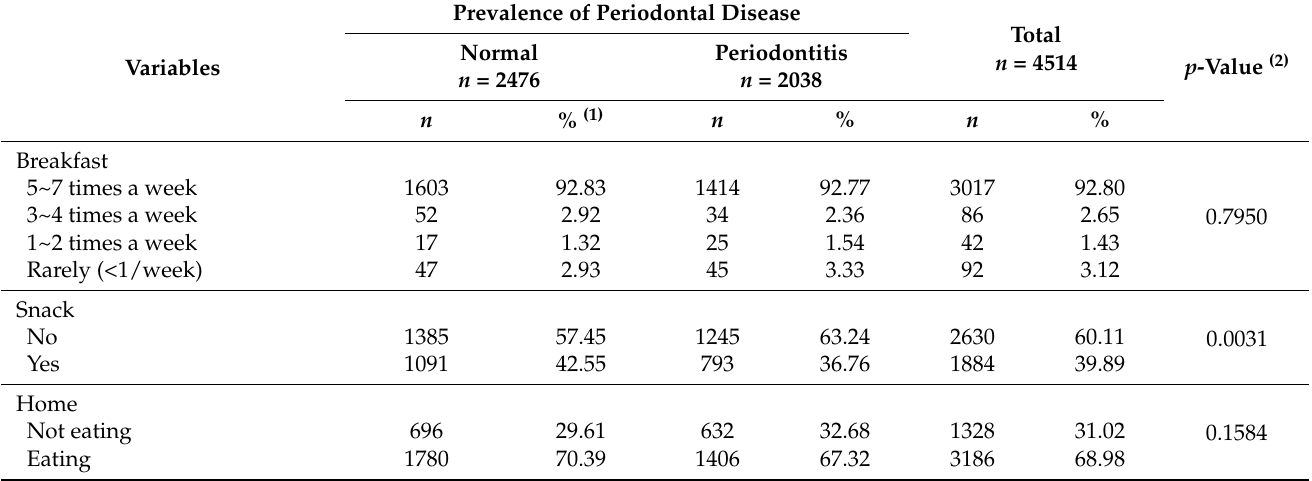
Table 3. Dietary behavior according to prevalence of periodontitis in survey